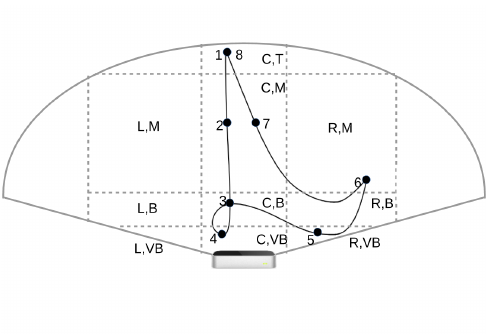
Fig. 7: Sequential positions of the user’s hand, tracked by the Leap Motion : (1-C, T), (2-C, M), (3-C, B), (4-C, VB), (5-R,